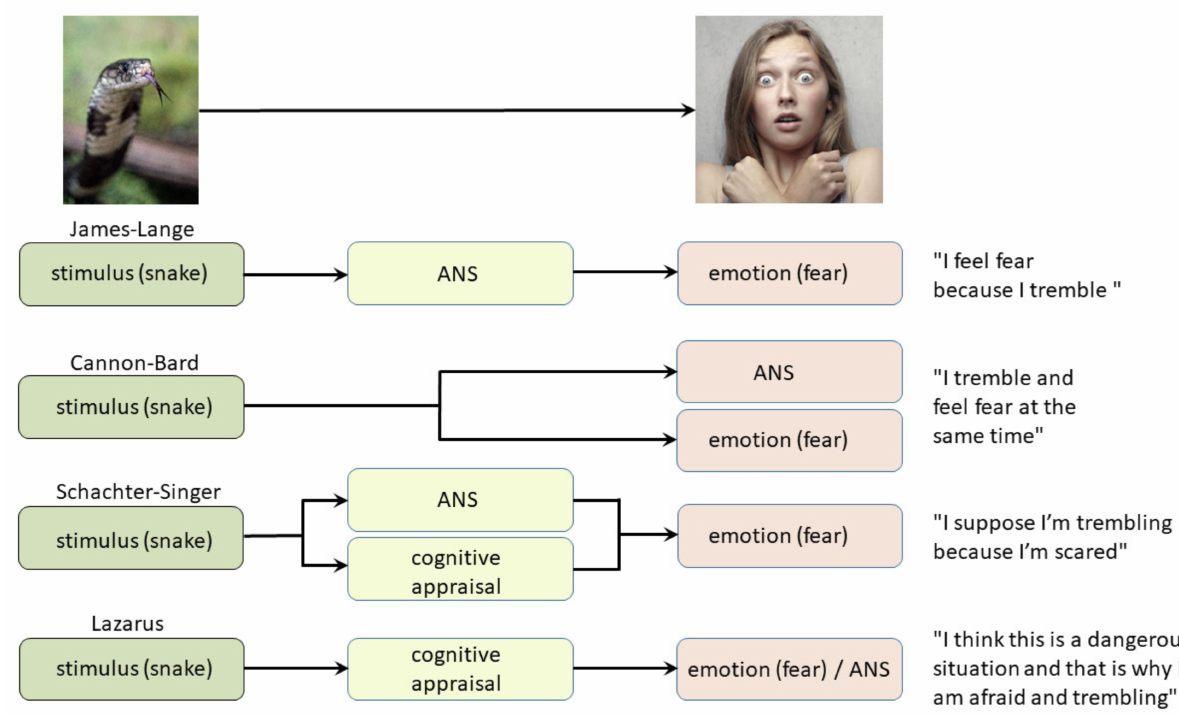
Figure 3. Simplified schematic representation of classical theories of emotion. Photographs taken from [9,48]. ANS— autonomic nervous system. See text for